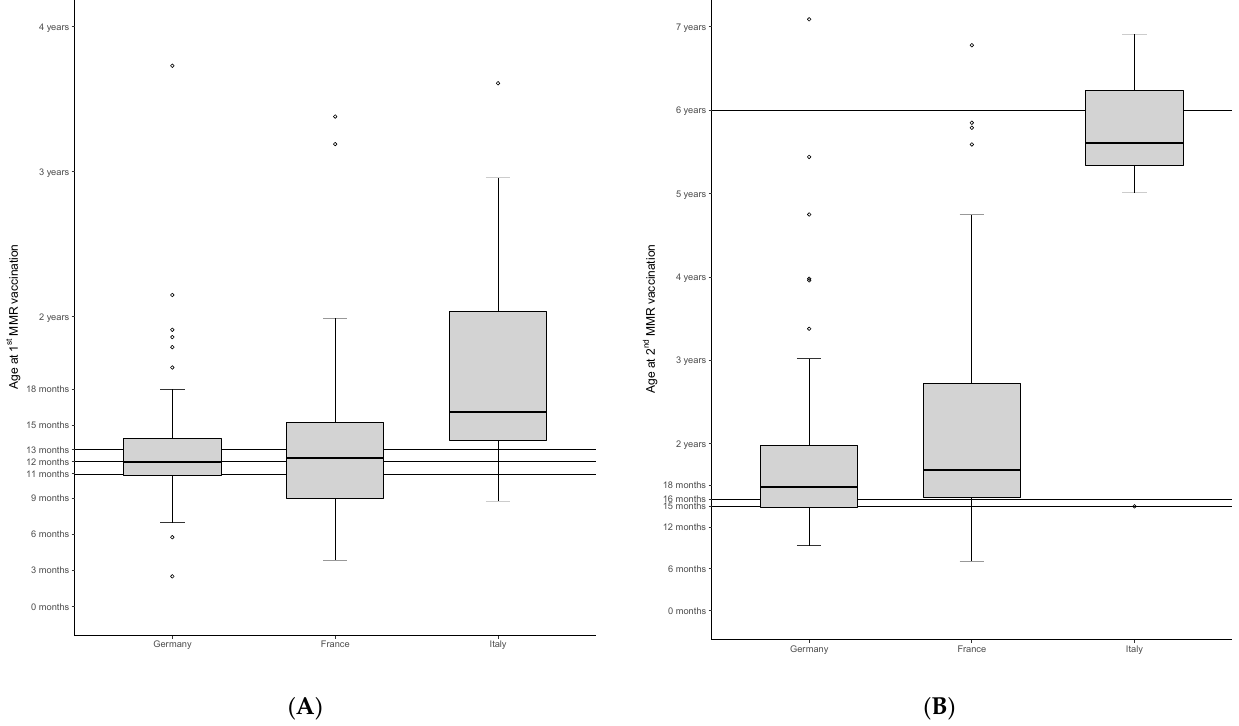
Figure 1. Boxplots with median age and interquartile range of vaccination age of 1st ( A ) and 2nd ( B ) MMR vaccines of children with chronic liver disease in Germany, France and Italy. Outliers are plotted as points. The horizontal lines mark the recommended age for vaccination: for first dose MMR in Germany 11 months, in France 12 months and in Italy 13 months, followed by a booster dose at 15 months, 16 months and 6 years respectively. The graph demonstrates the delayed/insufficient vaccination rate in these children in these three countries.